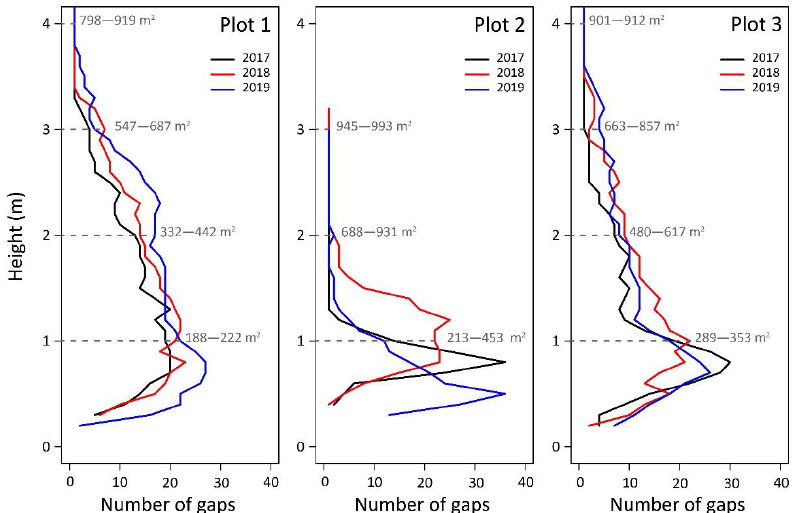
Figure 5. Dynamic gap analysis across the three monitoring plots for each monitoring year, showing the number of gaps in each vertical slice through the plot-level point cloud from 20 cm to 4 m above the ground. Each line corresponds to a monitoring year (black, 2017; red, 2018; blue, 2019). The grey text gives the estimated range for total size (m 2 ) of the gaps across the years for each meter interval.